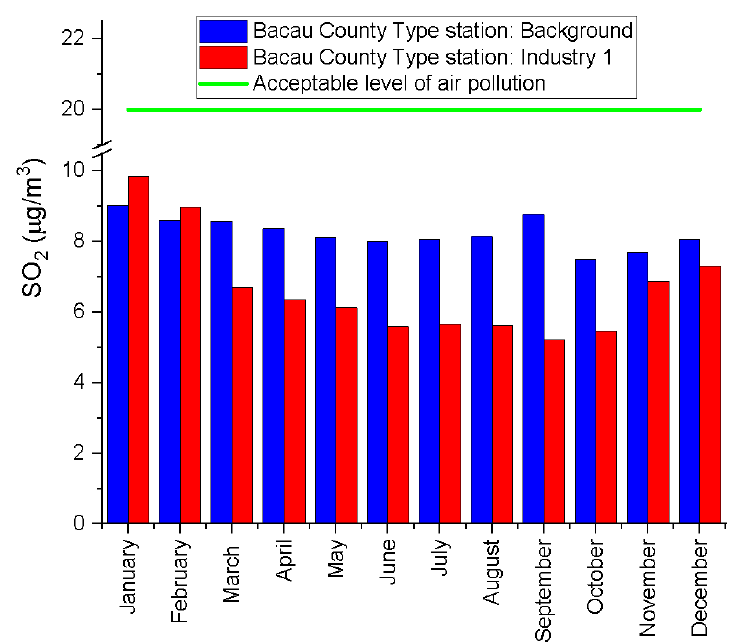
Figure 24. Average SO 2 concentration in individual months of 2020.